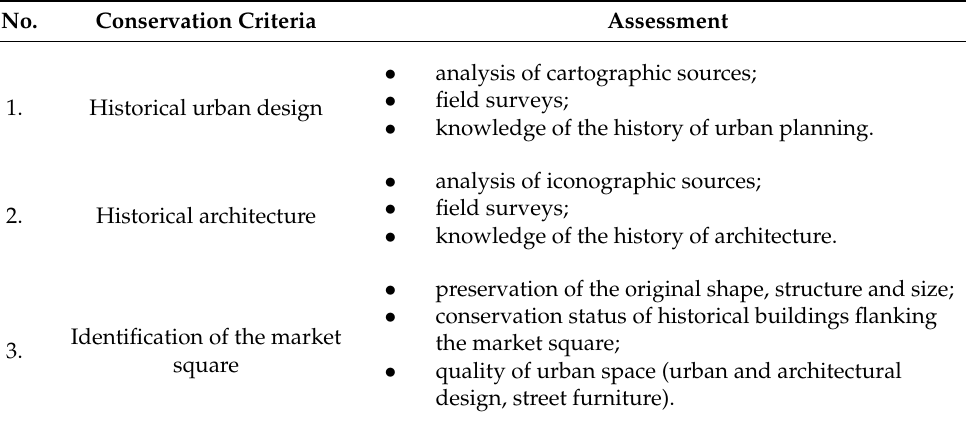
Table 7. The influence of urban components on perceptions of the